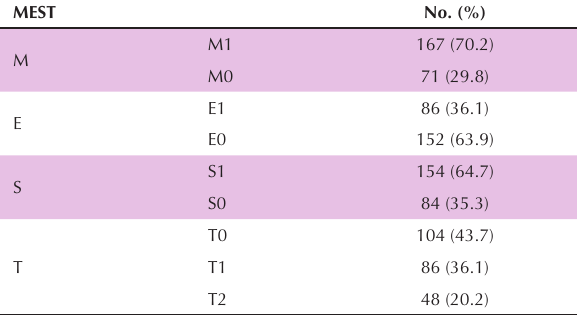
E (endocapillary hypercellularity), S (segmental sclerosis), tubular atrophy/ interstitial fibrosis (T), mesangial hypercellularity